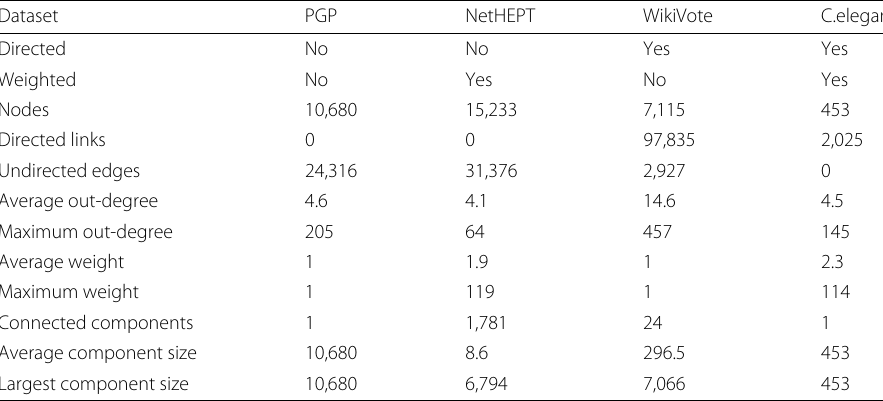
Table 1 Statistics of network